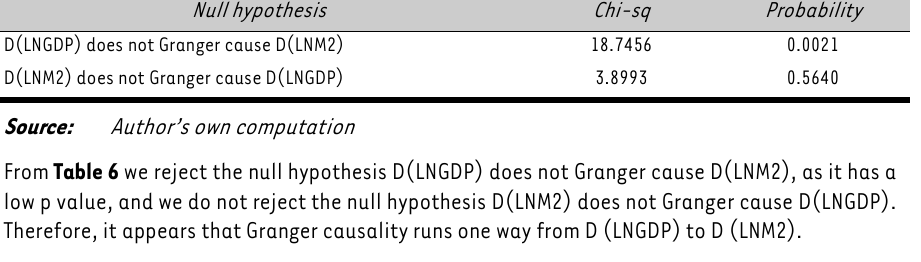
Granger causality test results between D(LNGDP) and D(LNPRIV) Null hypothesis Chi-sq Probability D(LNGDP) does not Granger cause D(LNPRIV) 78.4972 0.0000 D(LNPRIV) does not Granger cause